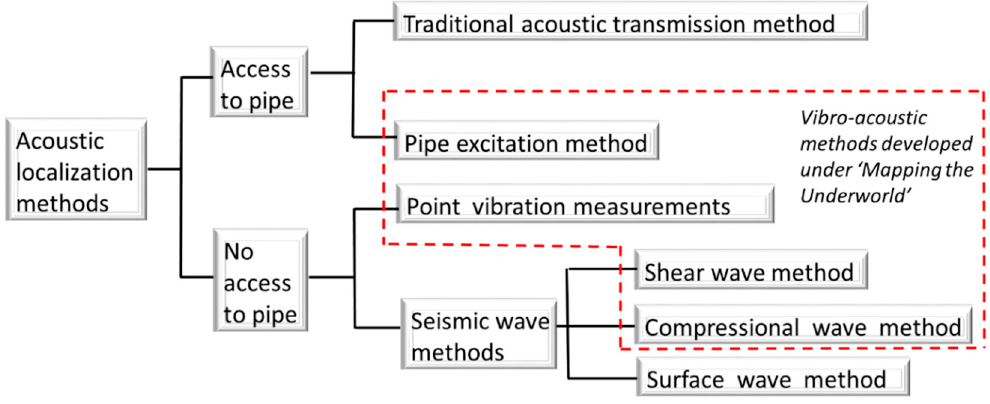
Figure 4. Overview of acoustic locating methods.